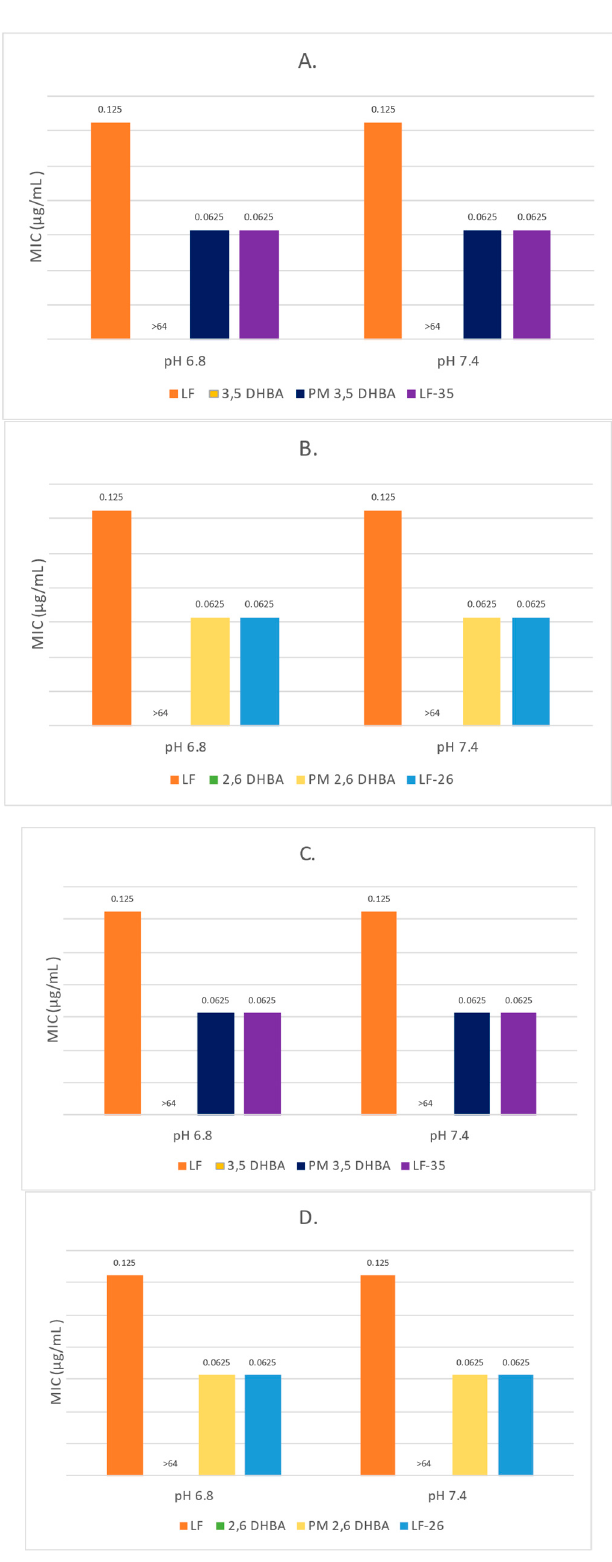
Figure 12. MIC comparison against Staphylococcus aureus ( A , B ) and Escherichia coli ( C , D ). Note: LF = levofloxacin, 3,5 DHBA = 3,5 dihydroxybenzoic acid, 2,6 DHBA = 2,6 dihydroxybenzoic acid, LF-26 = levofloxacin 2,6 dihydroxybenzoate, LF-35 = levofloxacin 3,5 dihydroxybenzoate, PM = physical mixture.